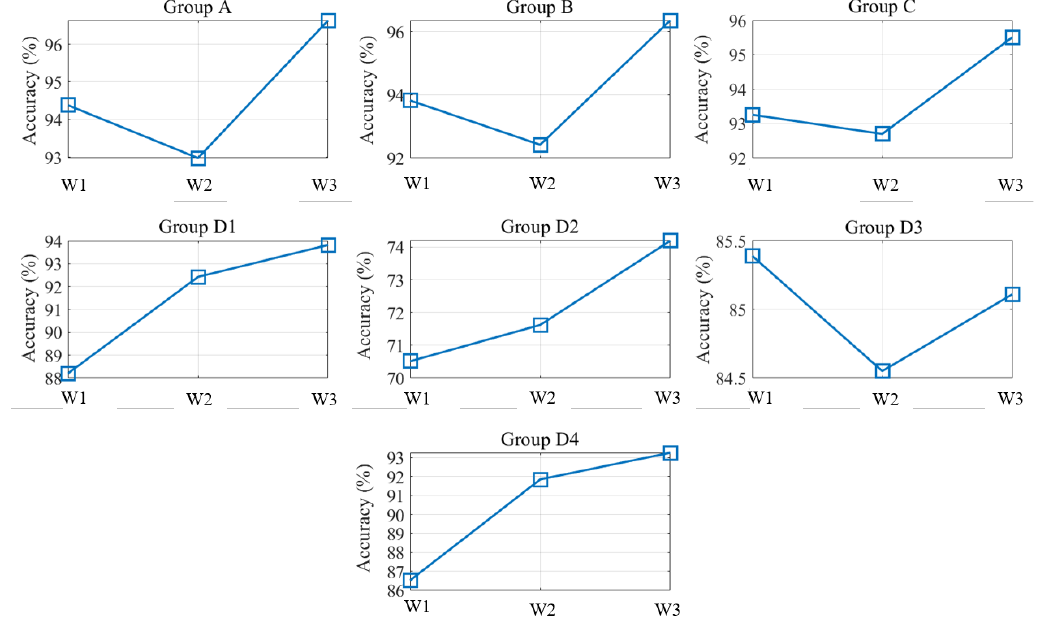
Figure 14. Training accuracy of the MLP model when R H/I = 1.